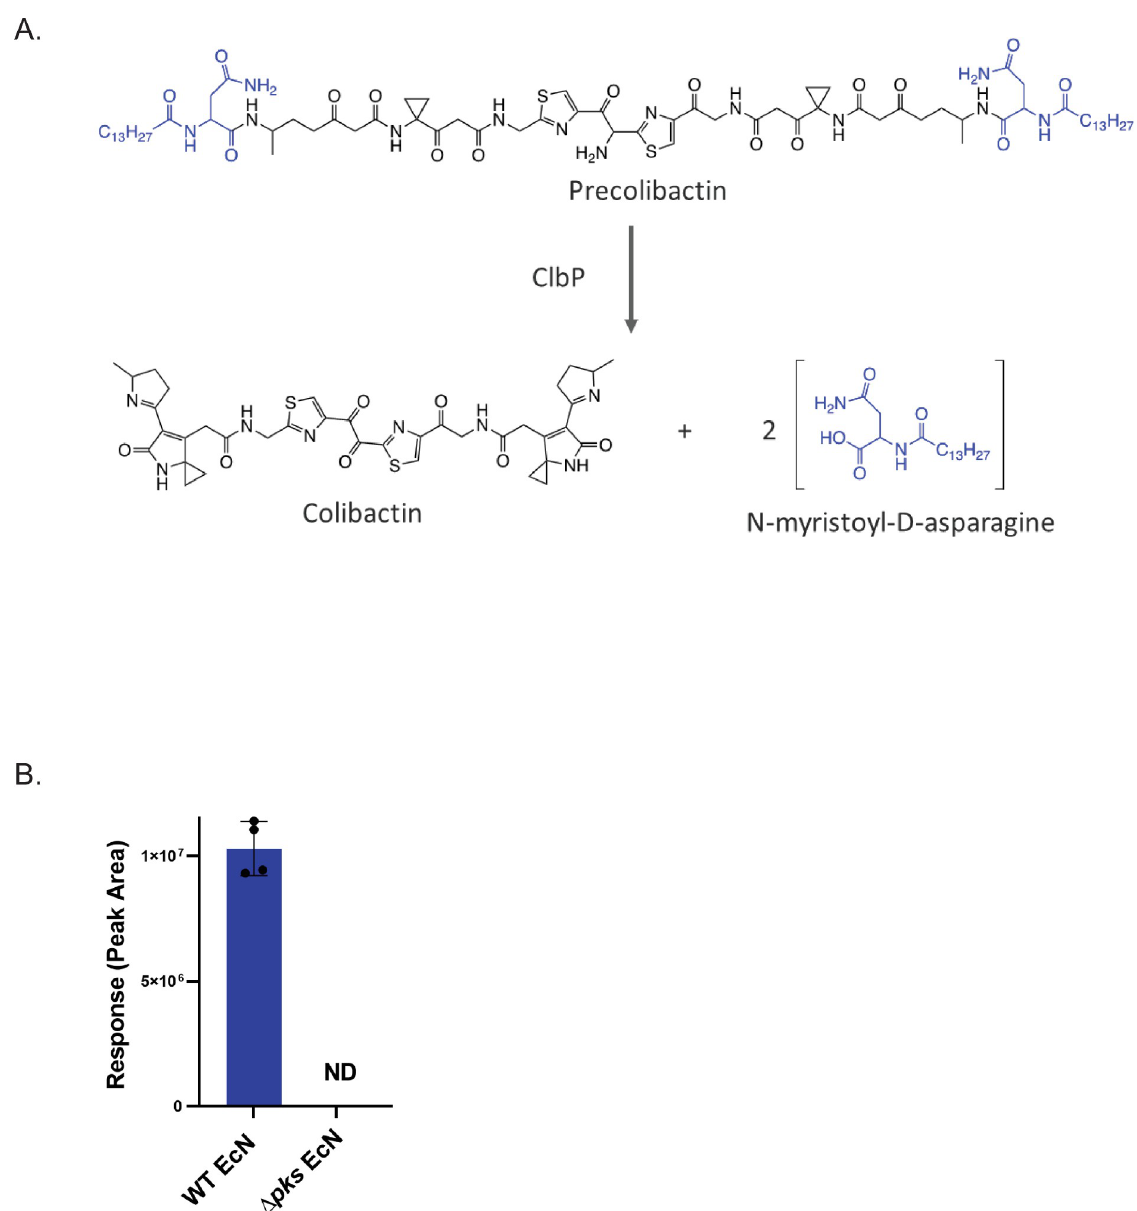
Fig 2. Δ pks EcN does not produce colibactin. A) The maturation of colibactin by ClbP results in two molecules of N-myristoyl-D- asparagine, which can subsequently be used as biomarker for colibactin production in EcN strains. B) N-myristoyl-D-asparagine is not detected in Δ pks EcN, while it is detected in WT EcN strain. ND, none